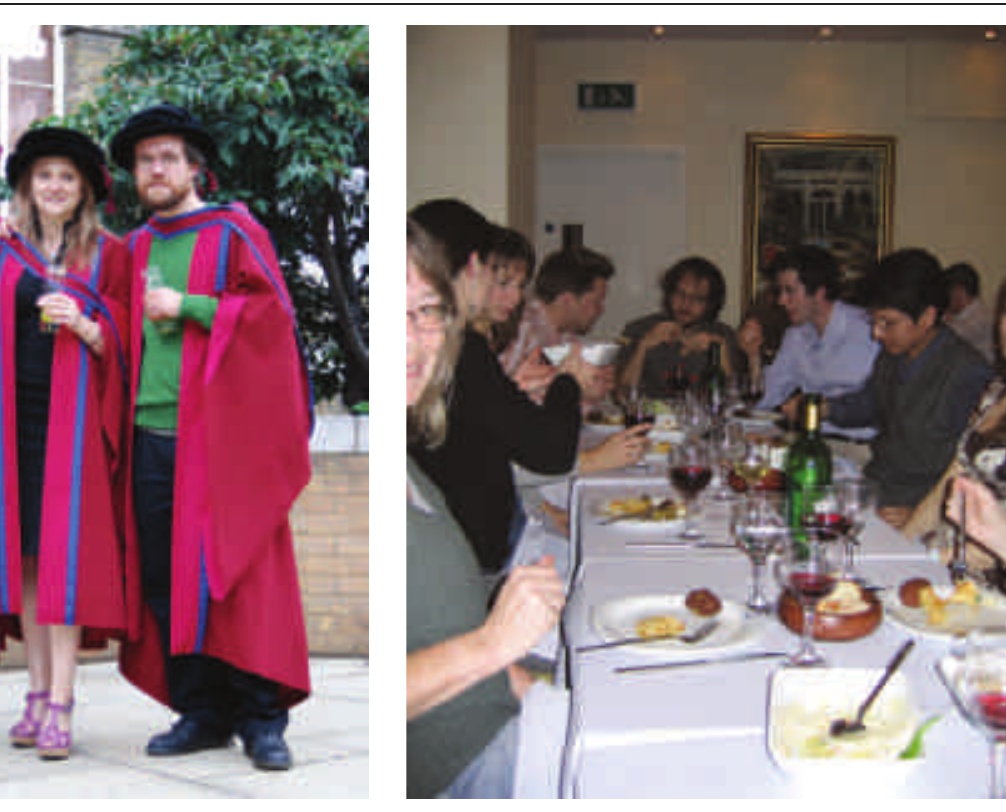
Figure 7 The flagged area of the Medieval barn